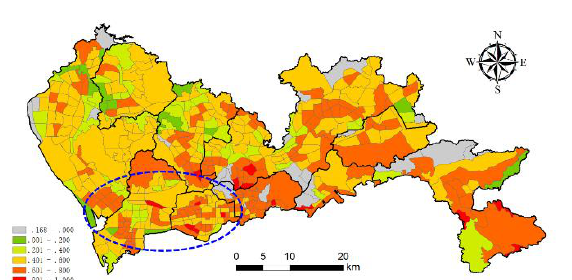
Figure 9. Correlation analysis result between hourly travel volumes in TAZ